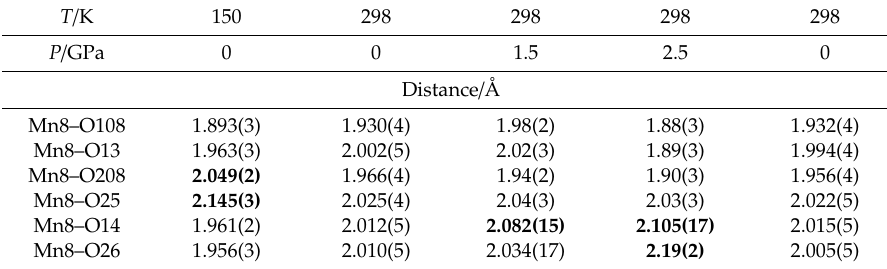
Table 4. Mn–O bond lengths at Mn8 as a function of pressure. Values for significantly elongated bonds are shown in bold.